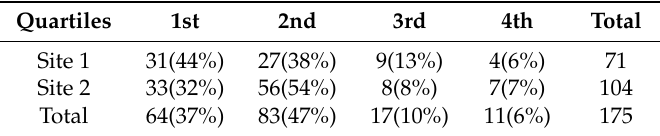
Table 2. The number of storms in each quartile defined according to the occurrence of peak rainfall